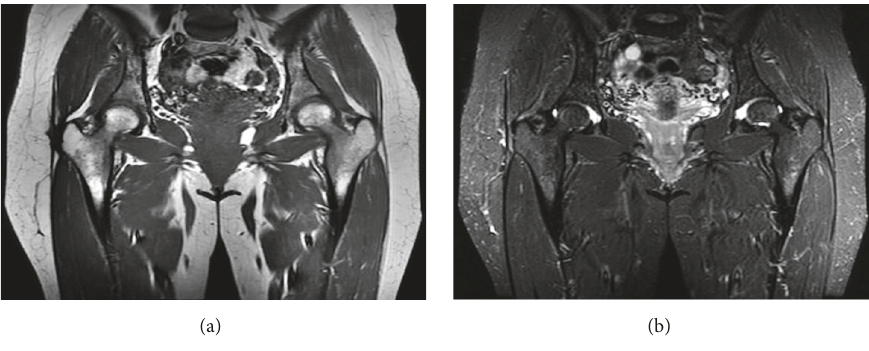
Figure 2: (a) Coronal T1 MRI. (b) Coronal T2